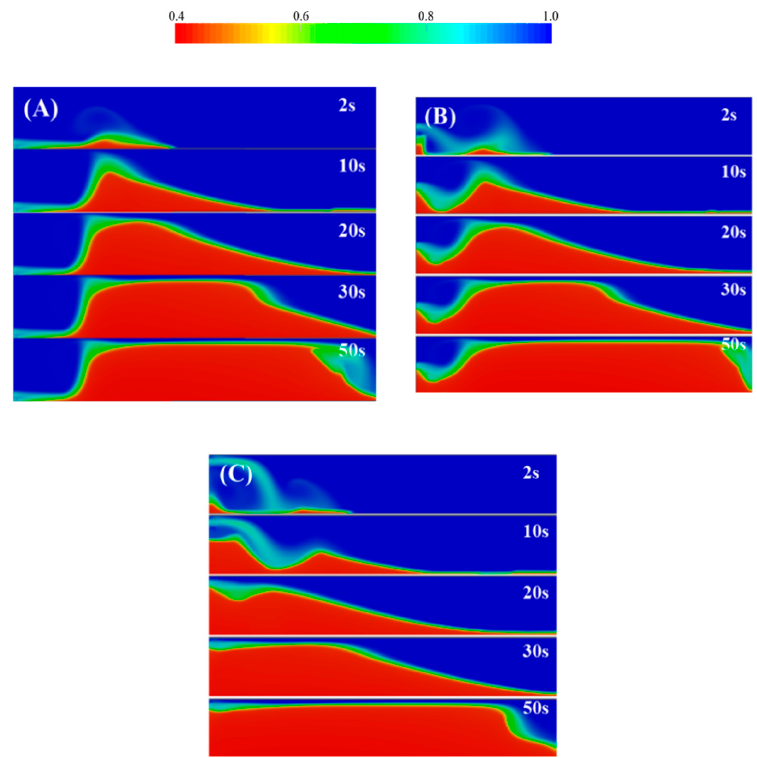
Figure 11. Proppant placement during the transport process for different inlet position cases: ( A ) Inject from the bottom inlet; ( B ) inject from the middle inlet; and ( C ) inject from the top inlet.